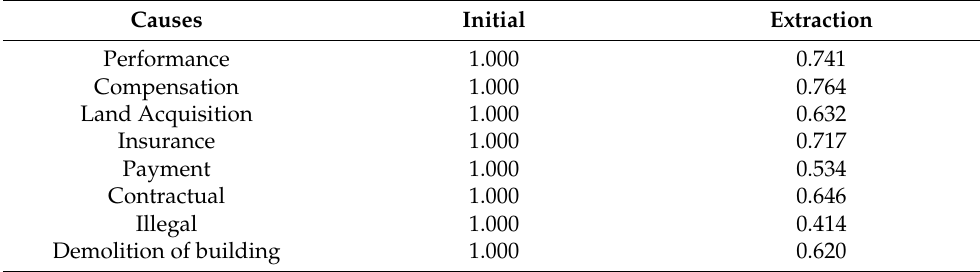
Table 7. Communalities of factors.